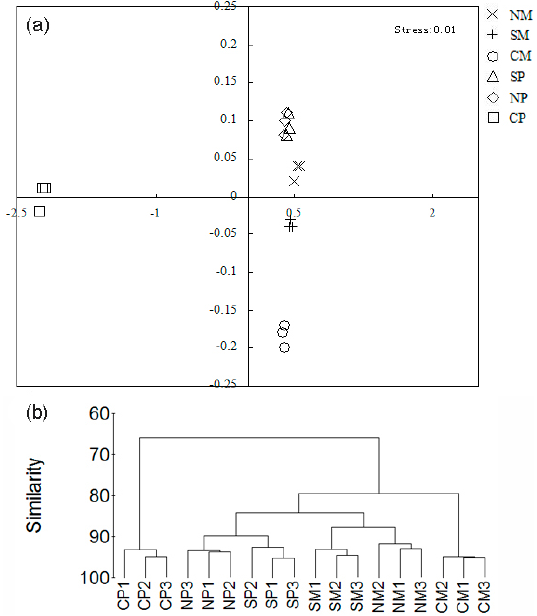
Figure 2. NMDS ordinations ( a ) and clustering analysis ( b ) of bacterial communities in soil. NM: non-separated maize; SM: semi-separated maize; CM: completely separated maize; NP: non-separated peanut; SP: semi-separated peanut; CP: completely separated peanut. Int. J. Mol. Sci. 2018 , 19 , x FOR PEER REVIEW 6 of 17 Table 3. Diversity analysis of rhizosphere soil bacterial communities under different intercropping patterns.